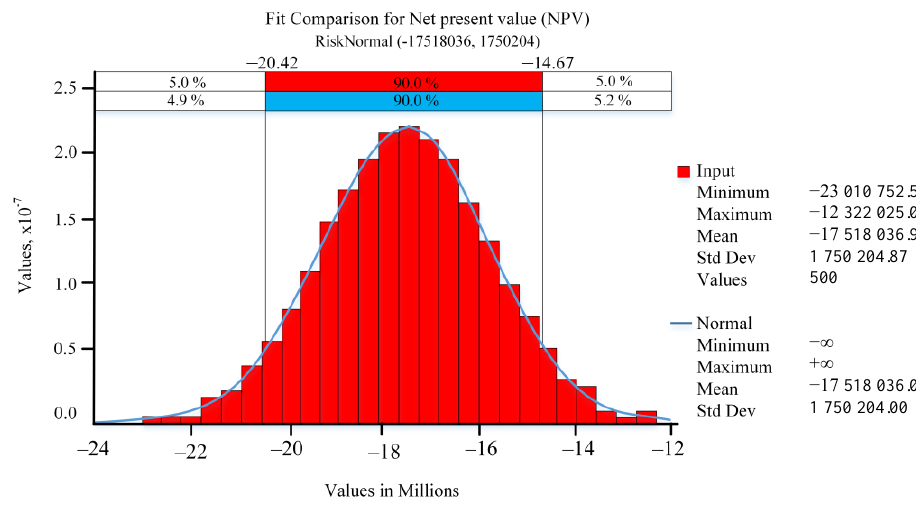
Fig. 13. Probability distribution of the